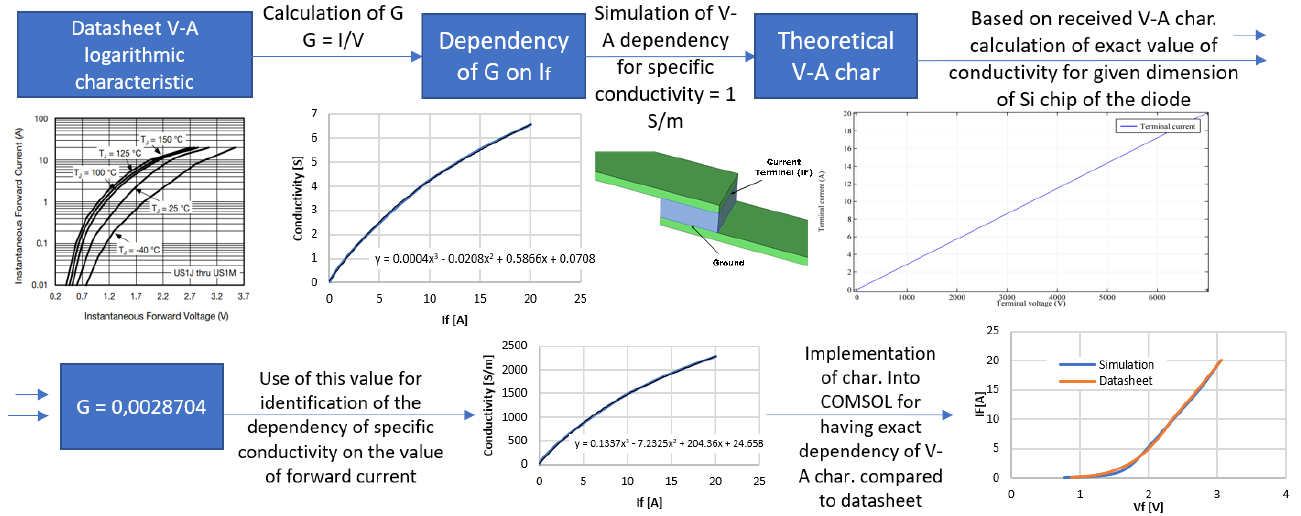
Figure 1. Simplified block diagram of the proposed approach (ε is electrical permittivity) .